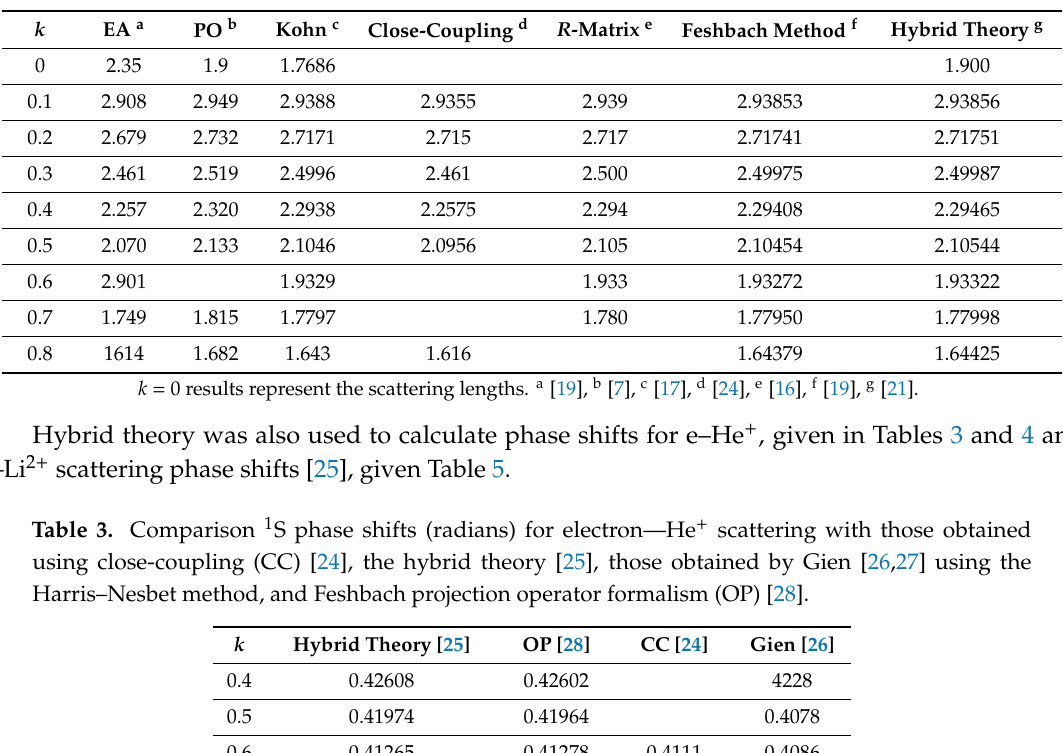
Table 2. Electron–hydrogen 3 S phase shifts (radians) obtained with di ff erent methods.